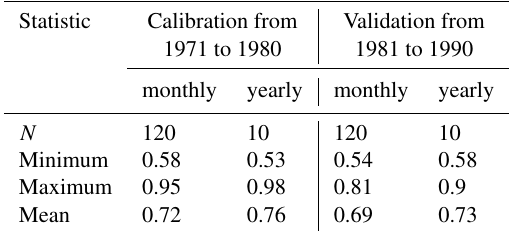
Table 4. Nash–Sutcliffe coefficient (Ens) statistics in the SWAT cal- ibration and validation